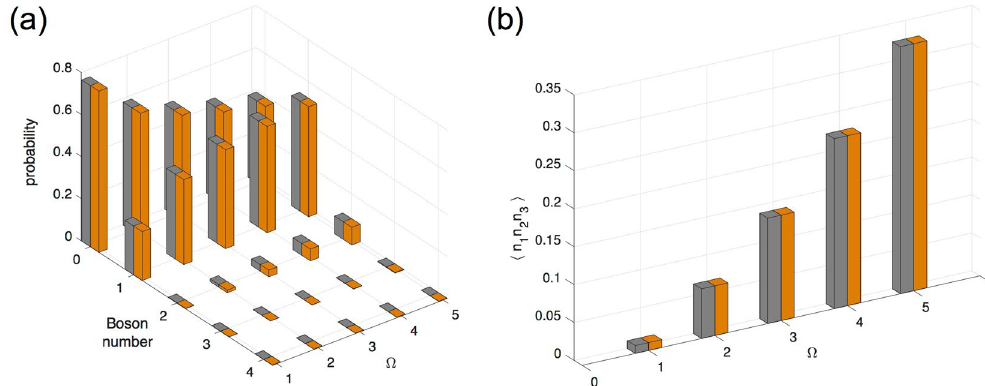
Figure 1. Boson number statistics for site 1 and three-site correlators under a number-conserving transformation in a uniform trimer. Gray bars correspond to the lower sign choice in the parameters listed in Table 1(a), Case 1; and orange bars correspond to the upper sign choice. (a) Boson number statistics as a function of drive strength Ω. (b) Three-site correlator as a function of drive strength. Although the NESS changes between the two different sign choices at each drive strength, the number statistics and the correlator remain the same.